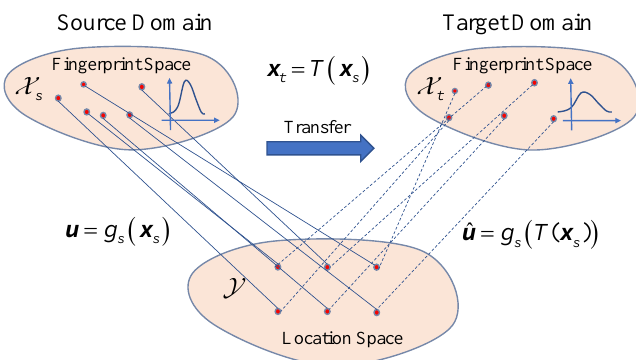
Figure 1. Schematic diagram of the transfer learning in FL based on